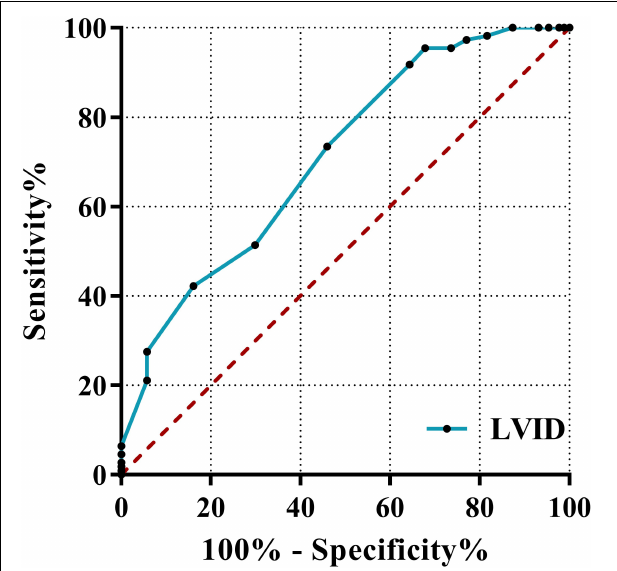
FIGURE 6 | Receiver operating characteristic curves of LVID. The ROC curve using the clinical diagnosis of cardiac function as the dependent variable and myocardial enzymes, BNP, and echocardiography indicators as independent variables. LVID, left ventricular internal diameter; ROC, receiver operating characteristic; AUC, area under the